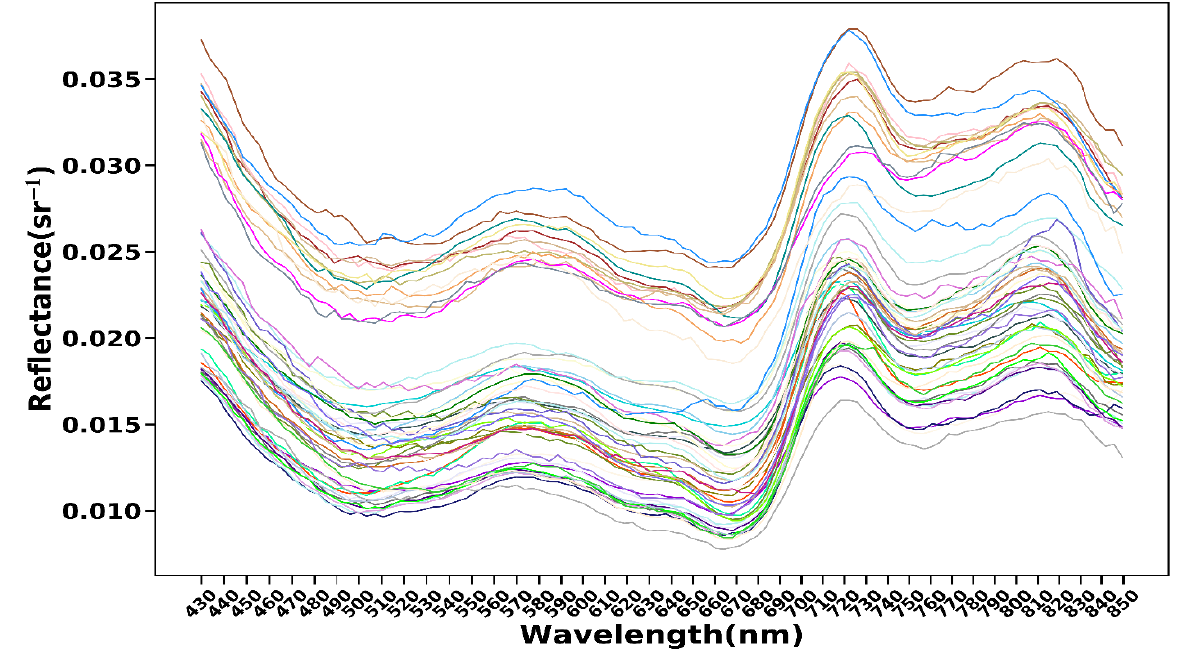
Figure 7. The reflectance spectral curves of water body. The lines with different colors represent 88 different experimental results.